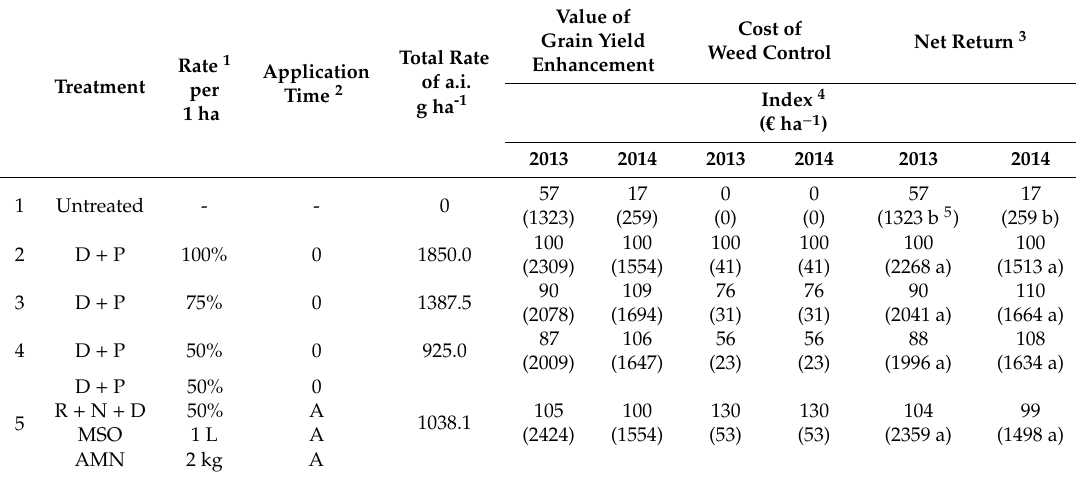
Table 5. Influence of herbicides on economic